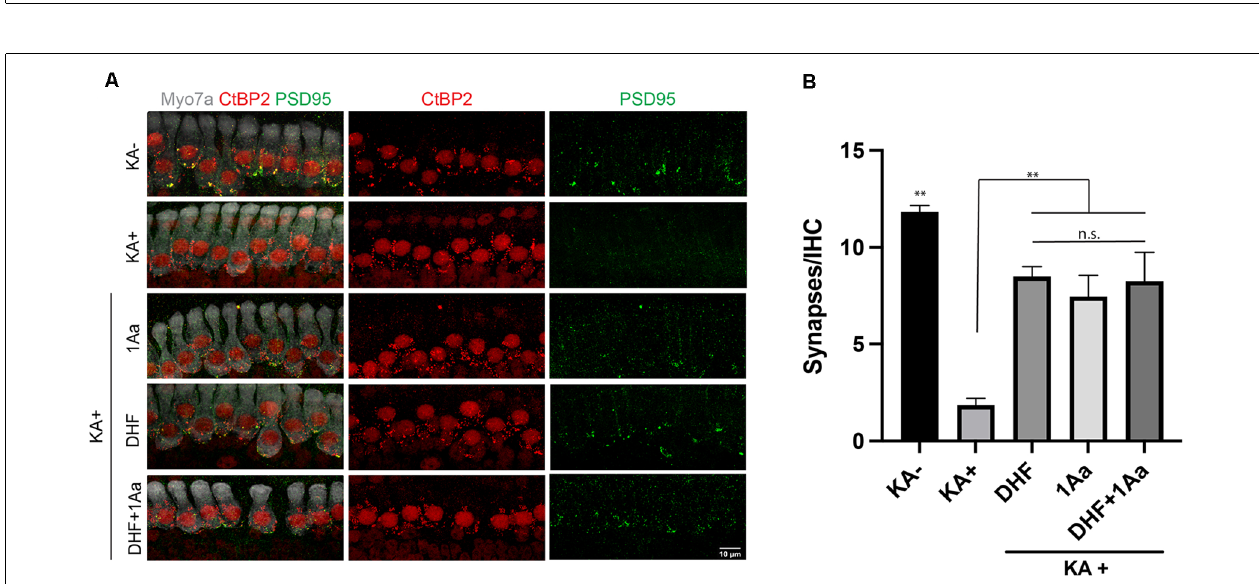
FIGURE 7 | 1Aa promotes synapse regeneration in vitro . (A) Immunohistochemistry of untreated control (KA-), control treated with KA (KA+), explant treated with KA+DHF (DHF), explant treated with KA+1Aa (1Aa), and explant treated with KA and 1Aa+DHF (1Aa+DHF). Hair cells were labeled with Myo7A (white), presynaptic ribbon synapse was labeled with CtBP2 (red), and postsynaptic ribbon synapse was stained with PSD95 (green). Images are representative of four independent experiments. Scale bar represents 10 µ m. (B) Quantification of number of synapses per inner hair cell ( ∗∗ represents p ≤ 0.01, n.s., not